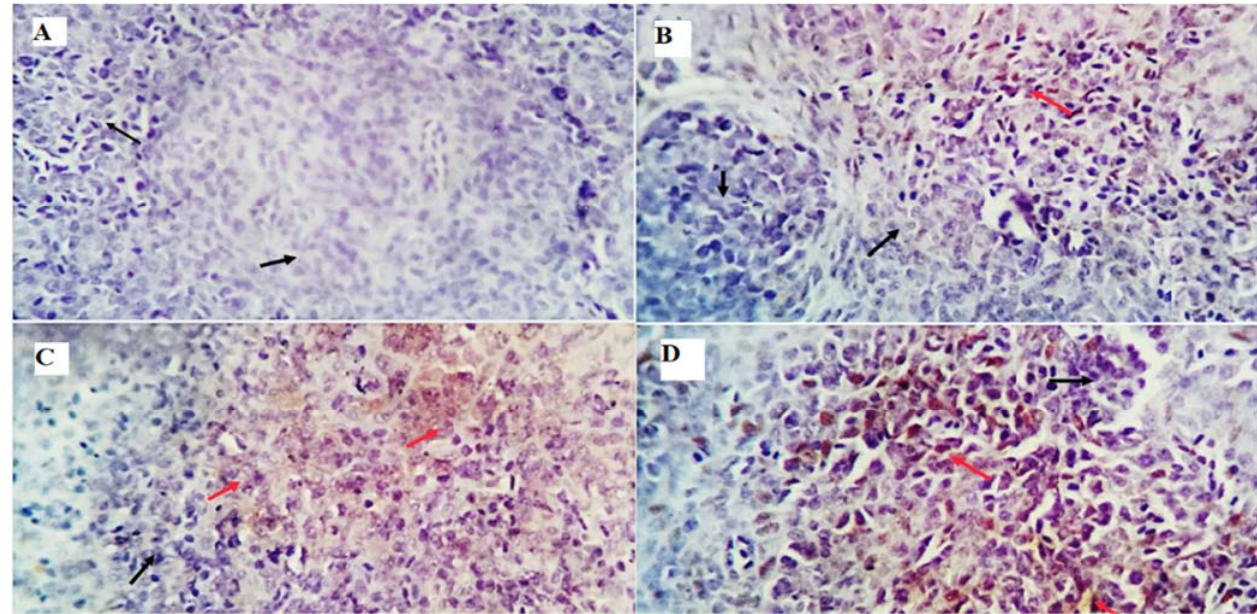
Figure 4. Immunostaining showing positive (red arrows) and negative (black arrows) CD3 cells in the spleen of broilers from different experimental groups. ( A ) FO0; ( B ) FO200; ( C) FO400; ( D ) FO600.